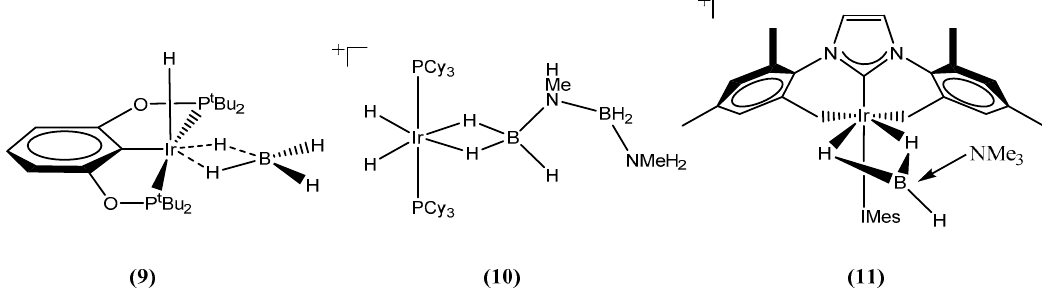
Figure 2. Intermediates detected during the dehydrocoupling of ammonia borane by catalyst (1), (3) and (5) respectively.